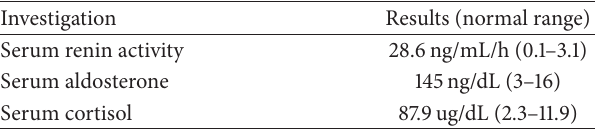
Table 2: Results of hormonal